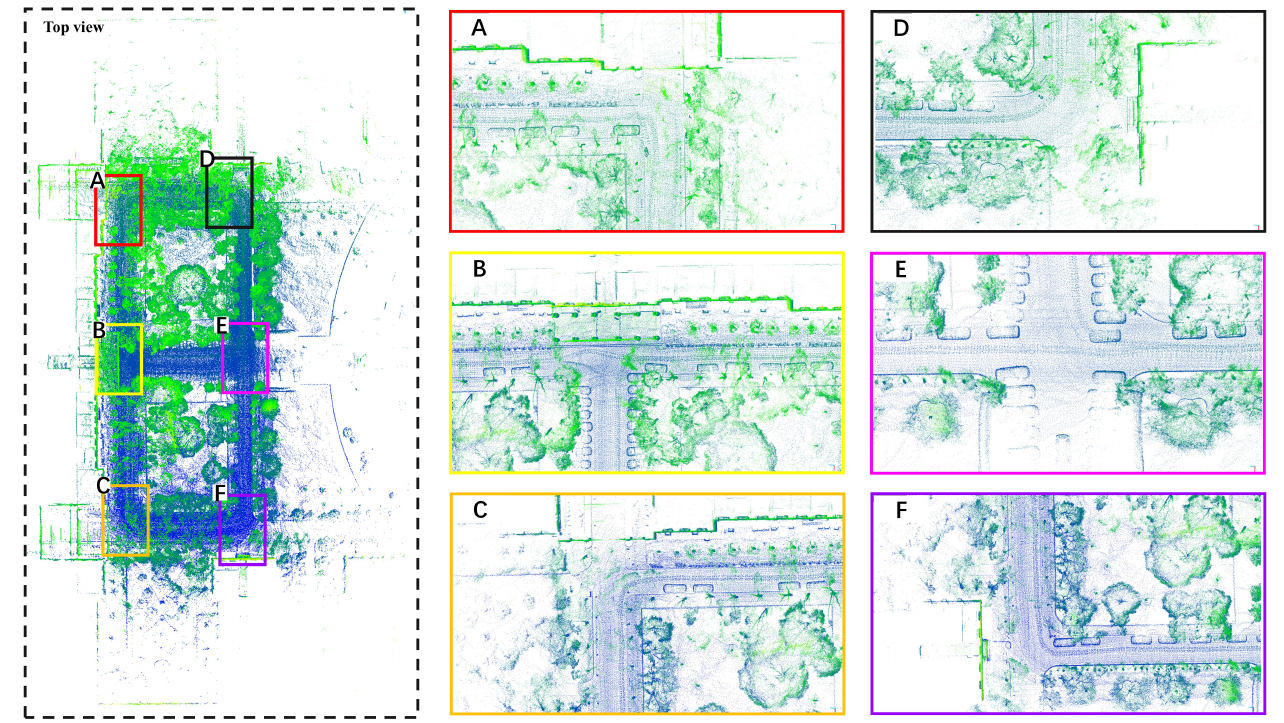
Figure 20. Mapping result of our approach on campus dataset, also shown are some representative regions from ( A – F